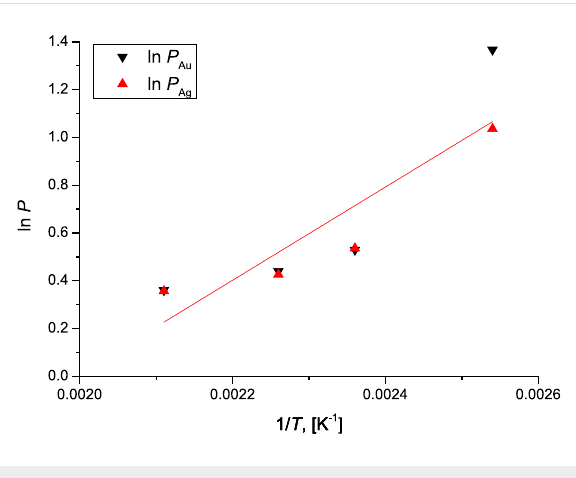
Figure 8: ln P ( P = D Ag / D Au ) versus 1/ T in the Ag/Au